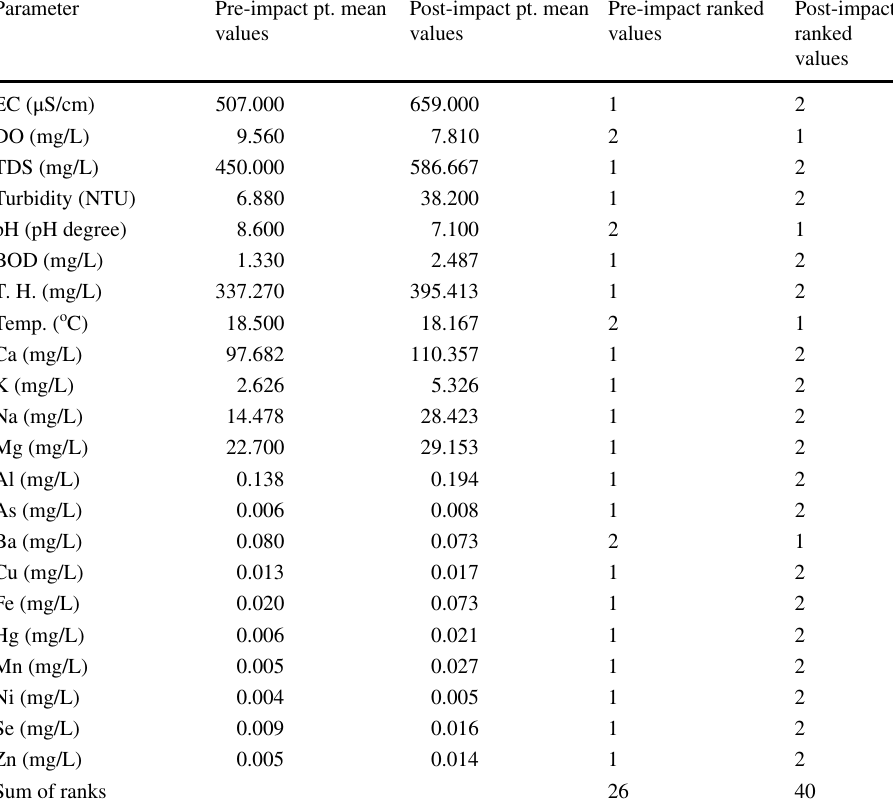
Table 2 The generated ranked values of the investigated variables using Friedman test analysis